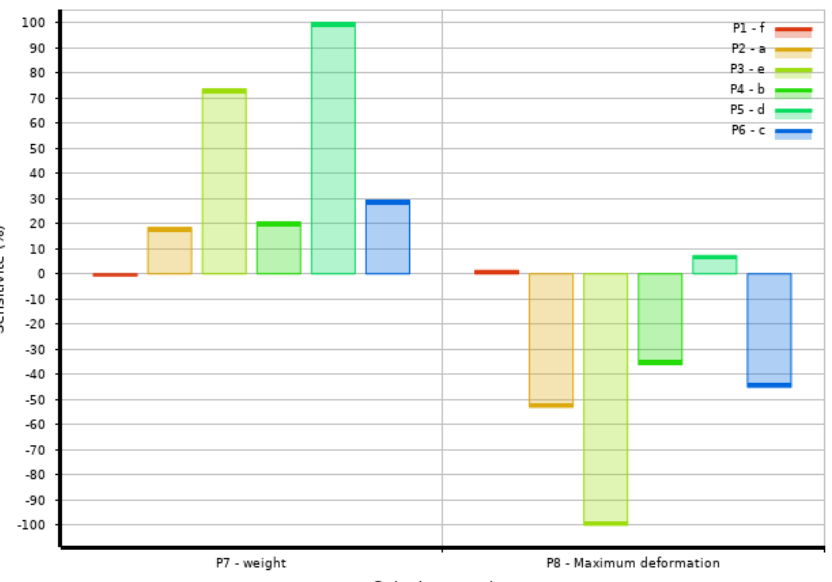
12 of 26 Table 3. Comparison of analysis results of three drive rods. Name